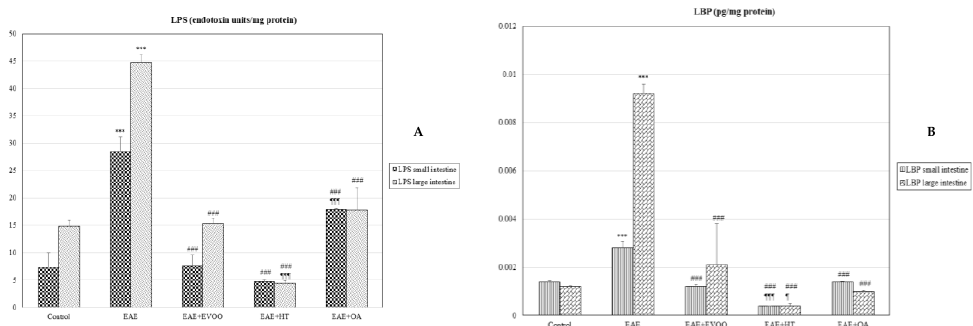
Figure 4. LPS (endotoxin units / mg protein ( A ) and LBP (pg / mg protein ( B ) in the small and large intestines: lipopolysaccharide (LPS) of the outside wall of the gram-negative bacteria and lipopolysaccharide binding protein (LBP) in the following study groups: control group (not manipulated); EAE group (experimental autoimmune encephalomyelitis induced by myelin oligodendrocyte glycoprotein (MOG)); EAE + extra-virgin olive oil (EVOO); EAE + hydroxytirosol group (HT); and EAE + oleic acid group (OA). *** p < 0.001 vs. control; ### p < 0.001 vs. EAE; ¶ p < 0.05 vs. EAE + EVOO; ¶¶¶ p < 0.001 vs. EAE + EVOO.